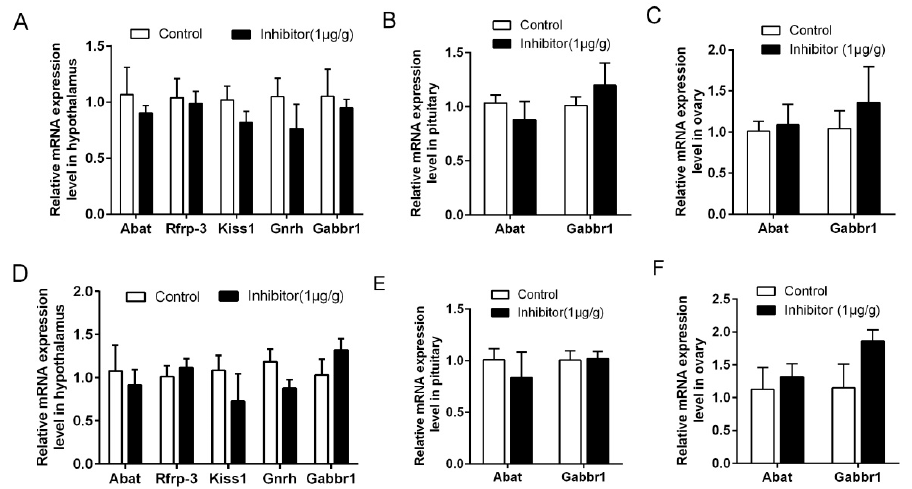
Figure 5. The expression of reproduction-related genes of 25d and adult rats after injected with GABA-T inhibitor for 4h. ( A ) Abat mRNA and reproduction-related genes levels in hypothalamus of 25d rats. ( B ) Abat and Gabbr1 mRNA levels in pituitary of 25d rats. ( C ) Abat and Gabbr1 mRNA levels in ovary of 25d rats. ( D ) Expression of Abat mRNA and reproduction-related genes in hypothalamus of adult rats. ( E ) Expression of Abat and Gabbr1 mRNA in pituitary of adult rats. ( F ) Expression of Abat and Gabbr1 mRNA in ovary of adult rats. Adult rat age is 64.58 ± 0.52 d. Vigabatrin was used as a GABA-T inhibitor.